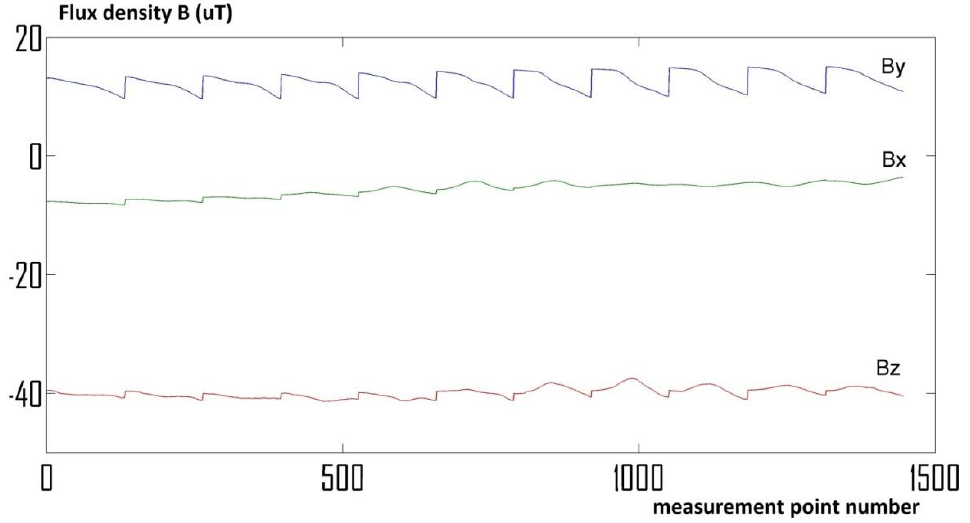
Figure 2. Raw measurements data collected using the magnetovision scanning